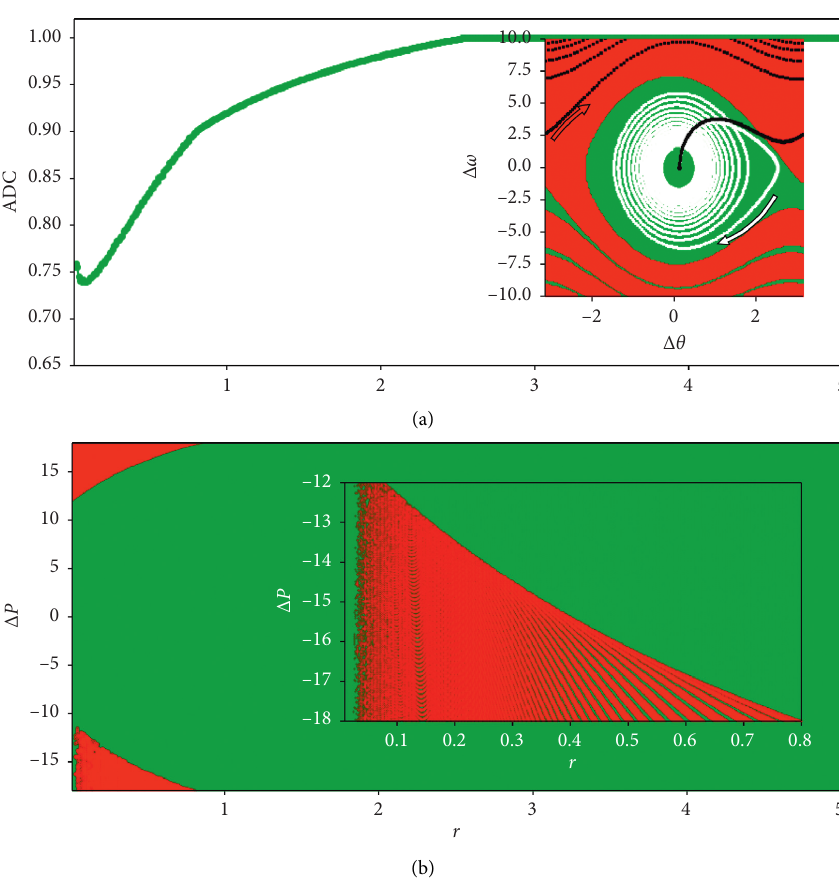
Figure 2: Stability of the two-node model. (a) The system antidisturbance capability ADC with respect to the synchronization rate r . Parameters are the same as in Figure 1 but with varied τ g . In the inset, two kinds of trajectories are projected in the phase space ( Δ θ , Δ ω ) , consisting of one leading the two-node model (8) back to the synchronous state colored in white and the other driving the system wandering periodically colored in black. (b) Perturbations located inside of the attracting basin are colored in green and outside of the region are colored in red as a function of r . Zoom-in part illustrate the complex structure of the local attracting region. Table 1: Parameters of generation response.